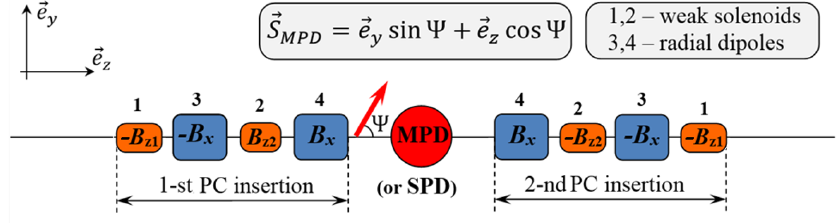
Figure 2. Scheme of the polarization control (PC) insertions in the NICA collider’s ST mode